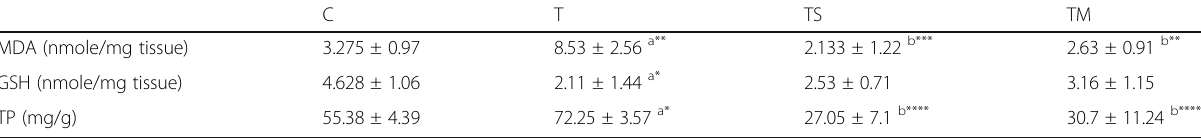
Table 4 Levels of lipid peroxidation, glutathione and total protein in liver homogenate of rabbits treated with SCG and MCG post CCl 4 -induced